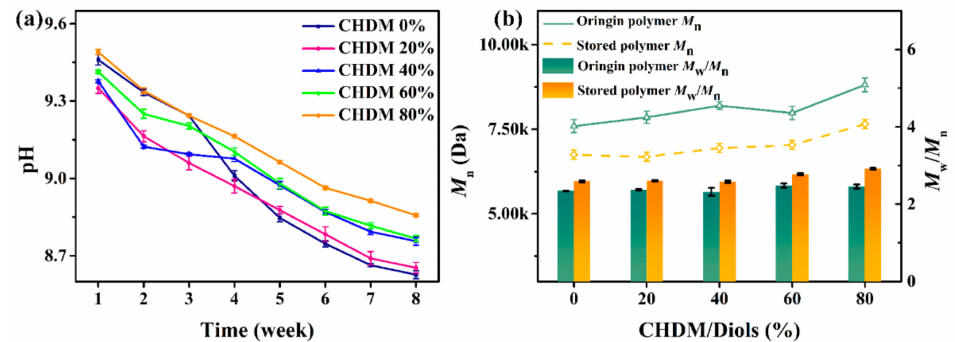
DSC curves of comb-like polyester and part of cross-linked polyester ( c ), and average particle size of dispersions ( d ) in different CHDM content.